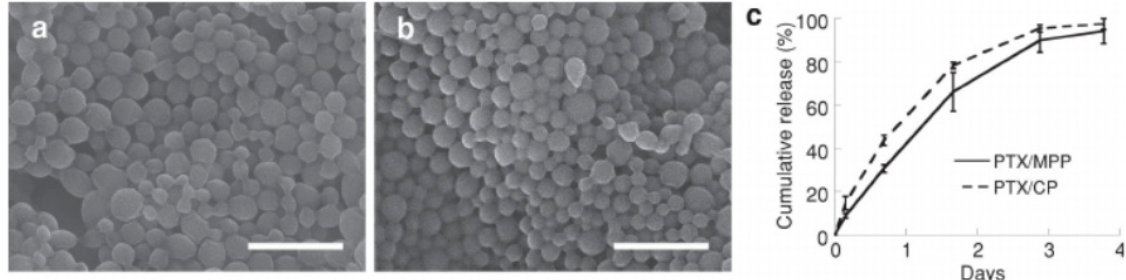
Figure 4. Characterization of PTX/PLGA nanoparticles in vitro. SEM images of ( a ) PTX/MPP and ( b ) PTX/CP; scale bar represents 1µm. ( c ) Cumulative in vitro release of PTX from PTX/PLGA nanoparticles over time [247].